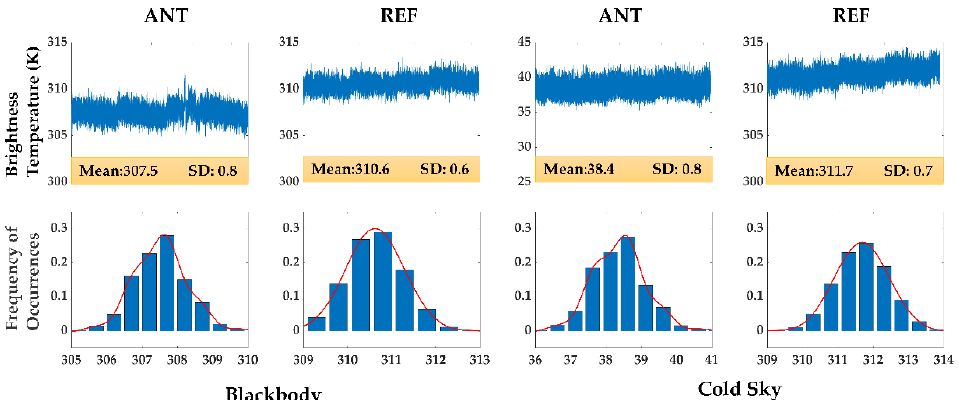
Figure 10. Radiometer measurement of blackbody and cold air TB ( top ) and its frequency distribution histogram ( bottom ).